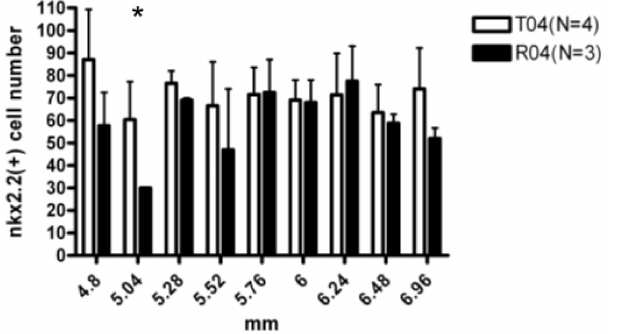
Figure 7. The Nkx2.2+ cells within the dorsal funiculus at 4.8 mm to nearly 7 mm. The total numbers